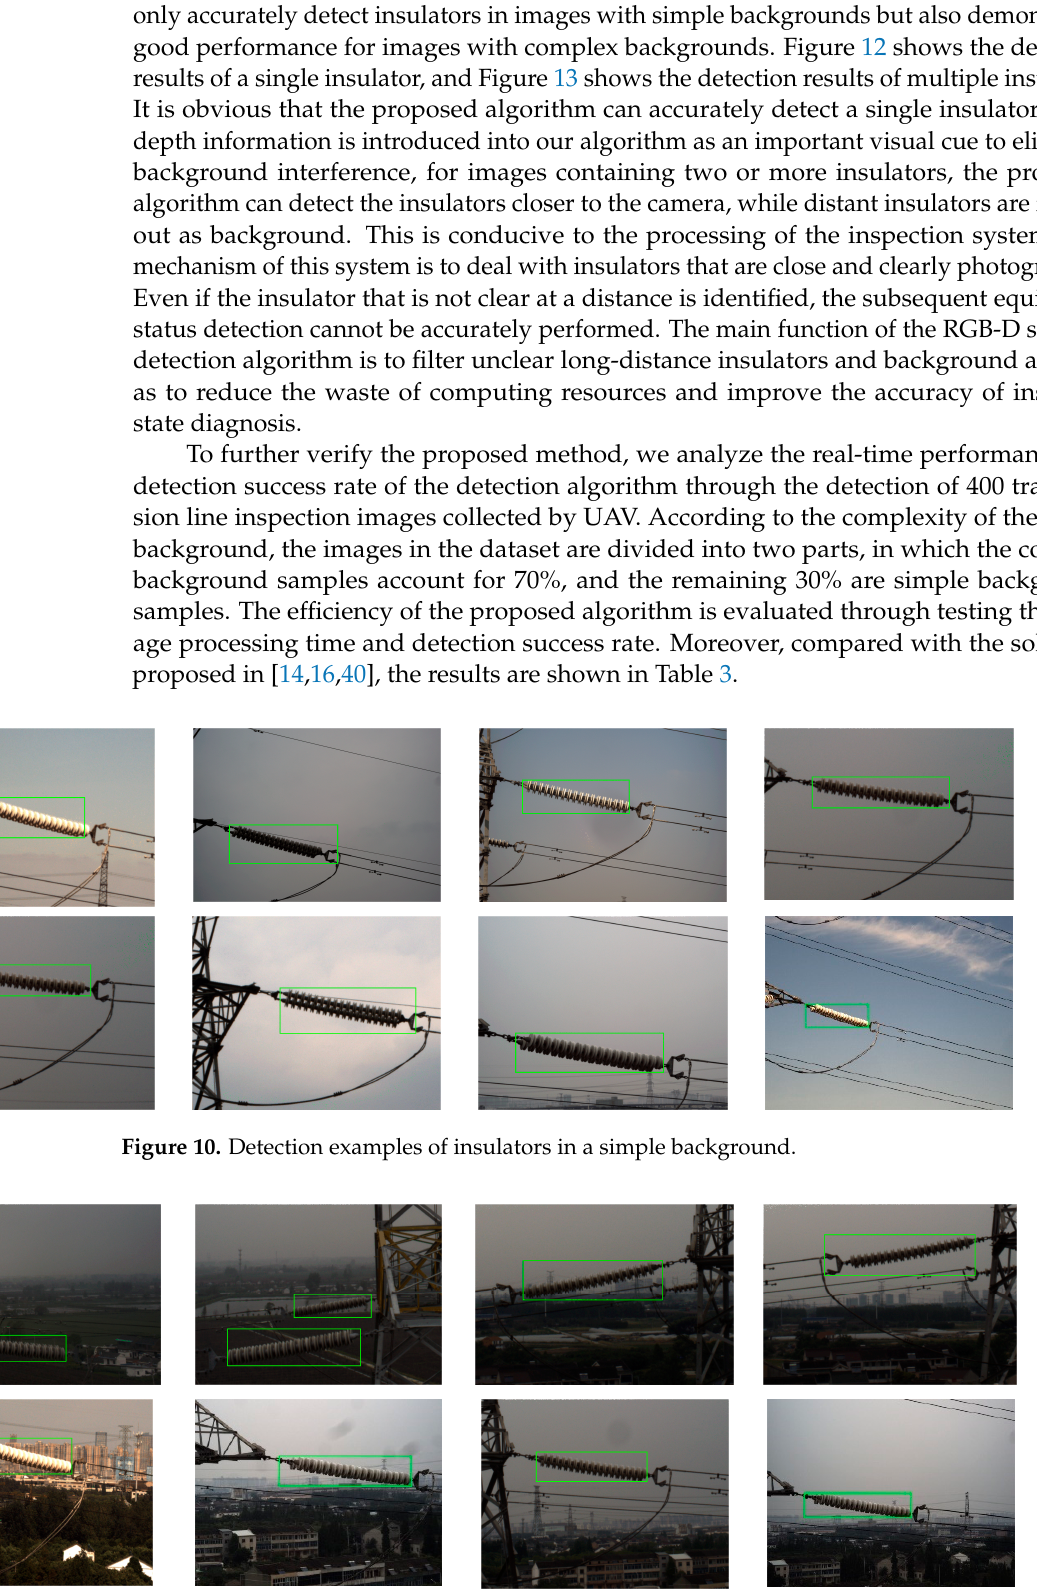
Figure 12. Detection examples of a single insulator.